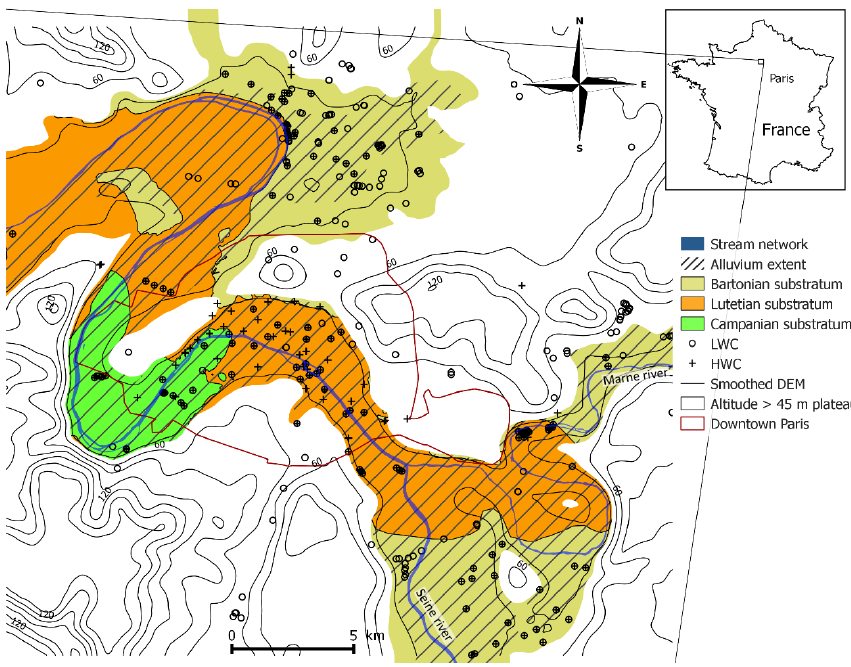
Figure 3. Alluvial plain and regional substratum of the Paris urban area. Piezometers location for the two campaigns: low water campaign (LWC) and high water campaign